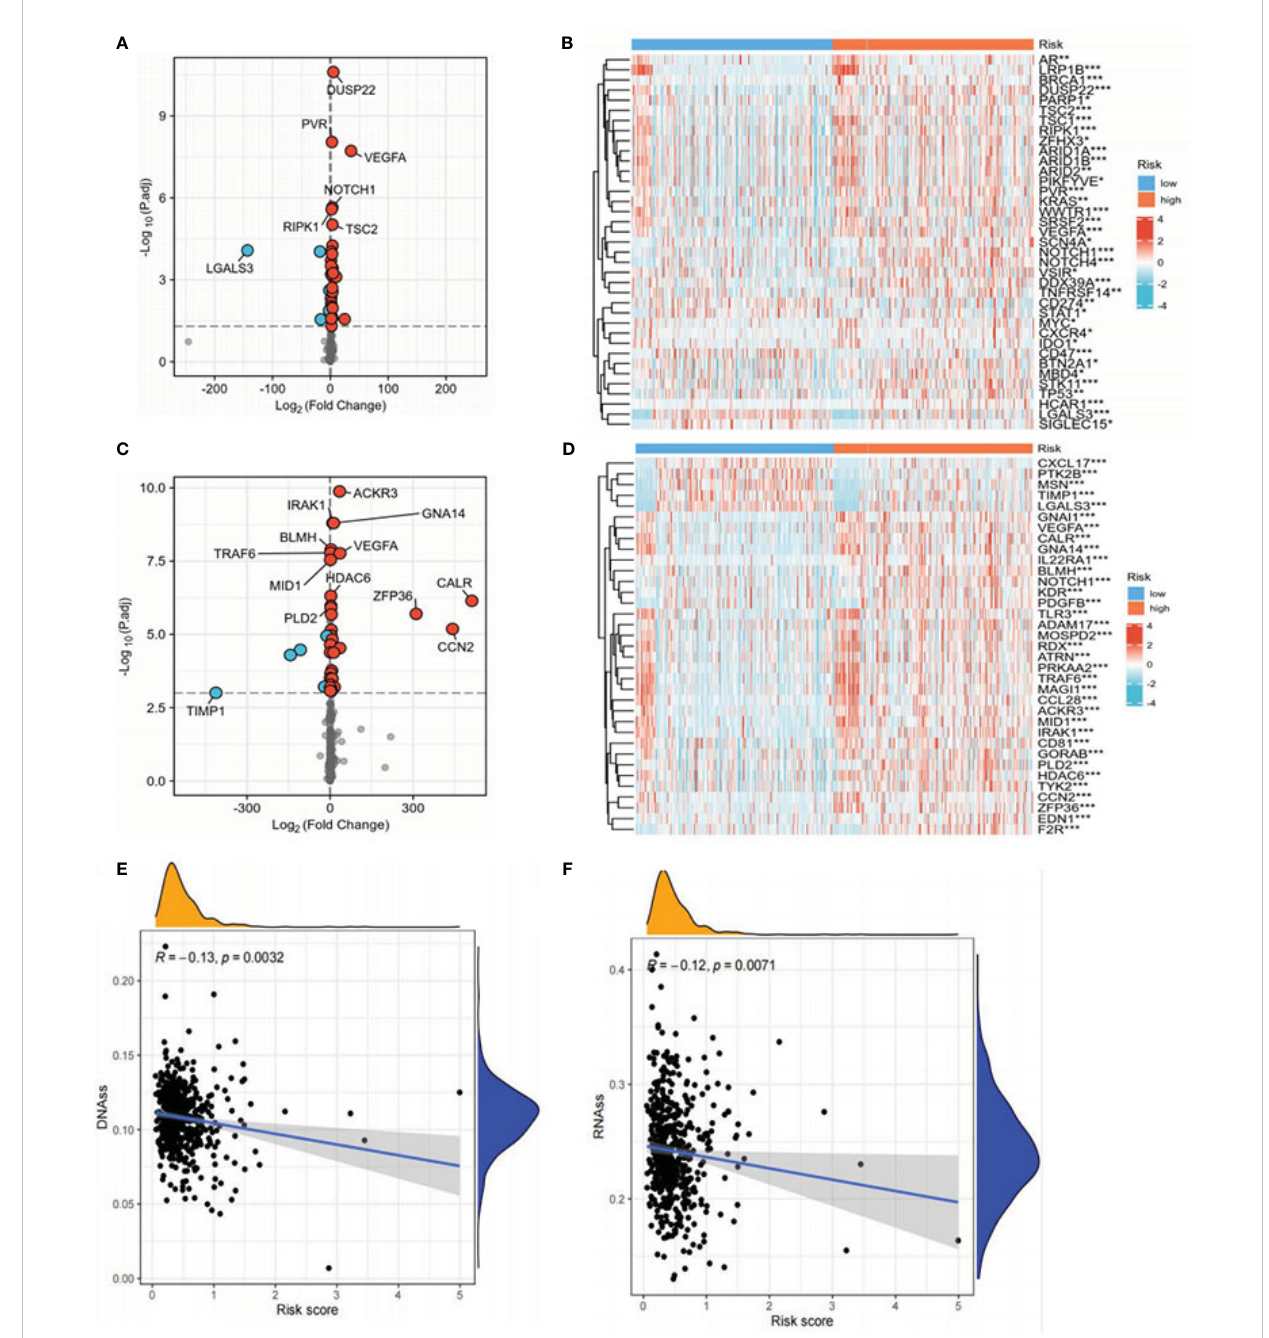
FIGURE 9 Expression of immune checkpoints, chemokines, DNAss, and RNAss in high- and low-risk groups. (A) Volcano plot of the distribution of immune checkpoint-associated genes in high- and low-risk groups. The right side of the vertical axis is P<0.05, log 2 FC >1, while the left side is P<0.05, log 2 FC<-1. (B) Heat map of the distribution of immune checkpoint-associated genes in the high- and low-risk groups. (C) Volcano plot of the distribution of chemokines in high- and low-risk groups. The right side of the vertical axis is P<0.05, log 2 FC >1, and the left side is P<0.05, log 2 FC<-1. (D) Heat map of the distribution of chemokines in the high- and low-risk groups. (E, F) The relationship between DNAss, RNAss, and risk scores (*P<0.05, **P<0.01, ***P<0.001, P<0.05 was considered signi fi